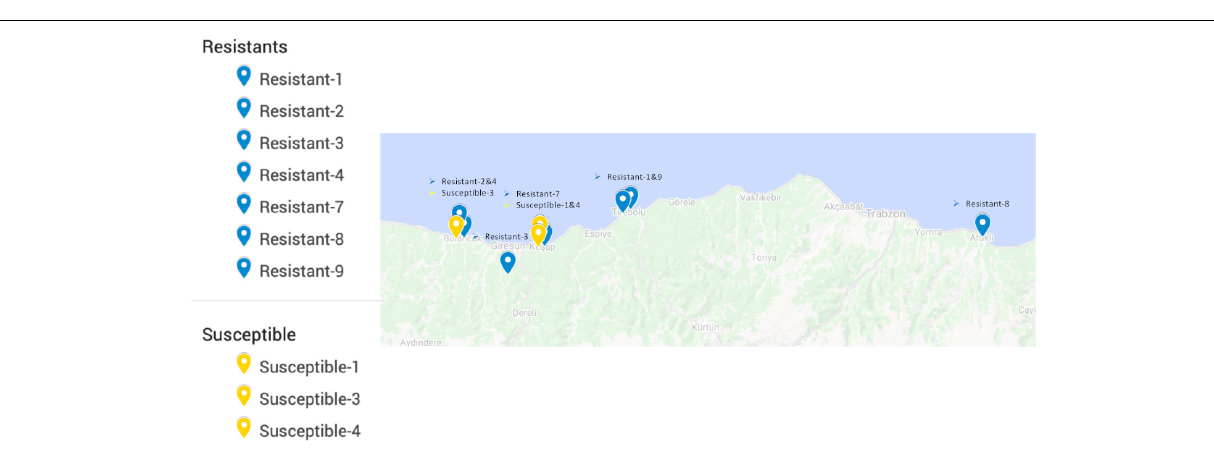
FIGURE 2 | Locations from which resistant and susceptible hazelnut accessions originated, prior to transplantation to the field gene bank at Giresun Hazelnut Research Institute. Records of the original location for one resistant and several susceptible individuals were not available, so these are not shown on the